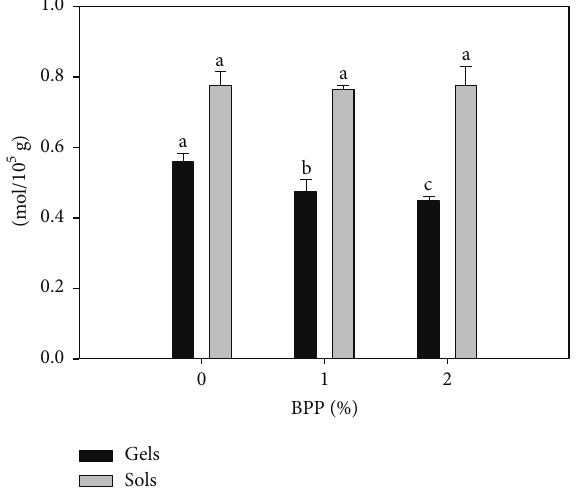
Figure 3: Effect of addition of BPP on the TSH content of sols and gels of protein concentrates from giant squid ( Dosidicus gigas ). Dif- ferent letters in the same group bars (sol or gel) indicate significant differences ( 𝑝 < 0.05